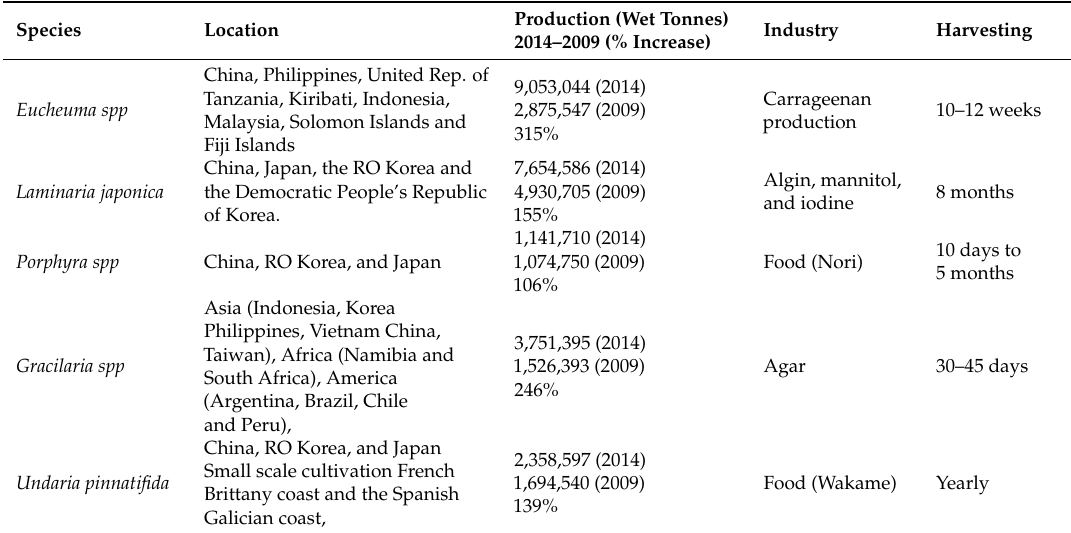
Table 1. Cultivated seaweed, production and industry